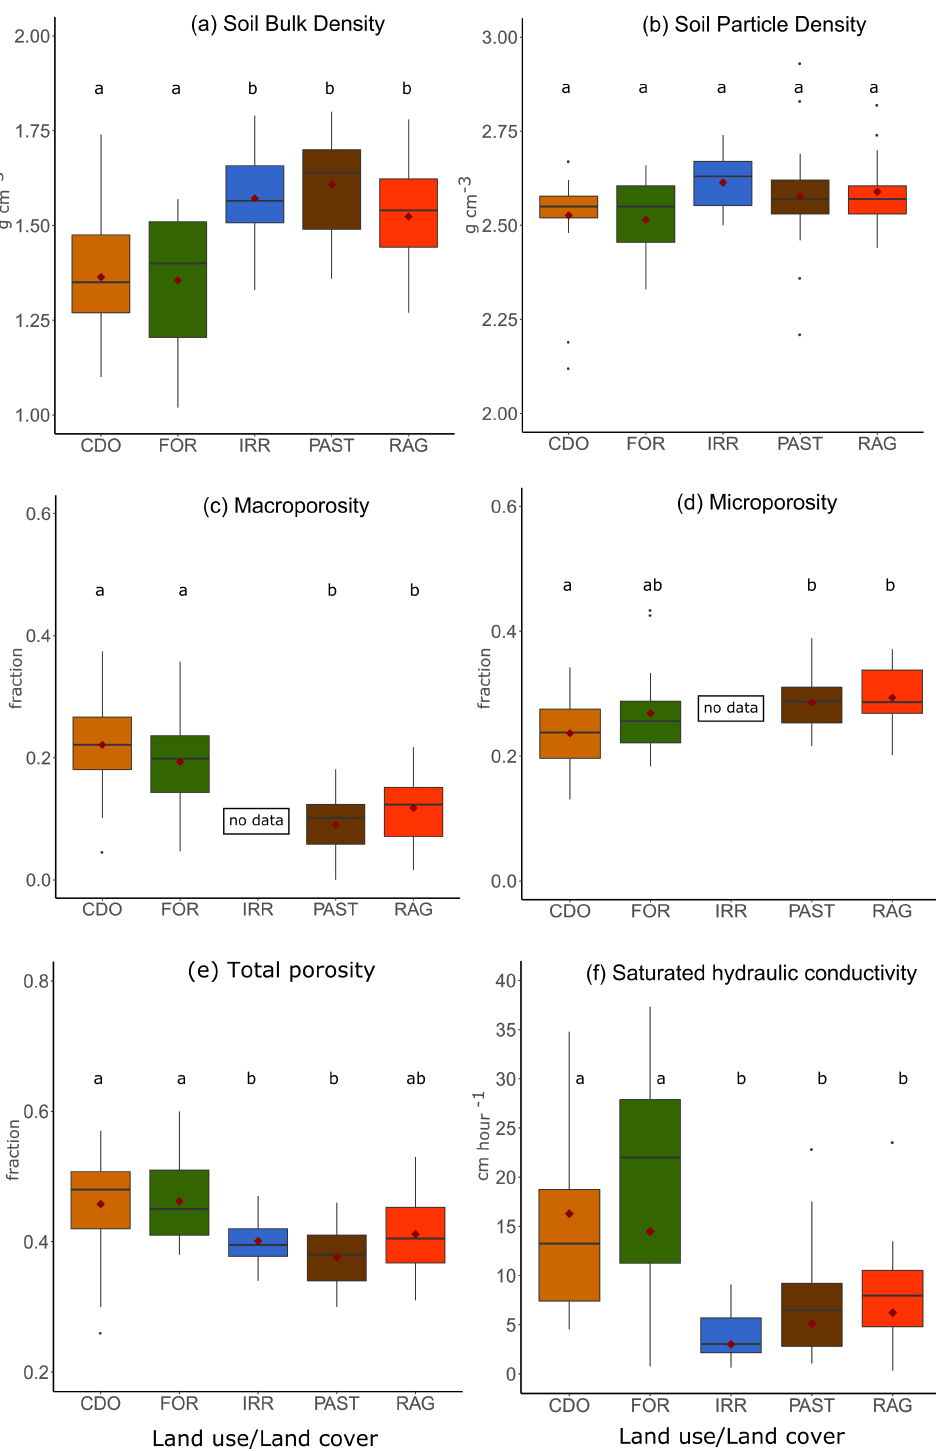
Figure 3. Soil hydraulic and physical properties considering 0–5 cm depth for different LULCCs in Western Bahia.In the box plots, the lower limit of the box indicates the 25th percentile, the black line within the box marks the median, the red point within the box marks the mean, and the upper limit of the box indicates the 75th percentile. Bars above and below the box indicate the confidence interval. The samples are distributed in Cerrado areas (CDO), n = 22; Forest formations (FOR), n = 19; Irrigated agriculture (IRR), n= 20; Pasture (PAST), n = 21; and Rainfed agriculture (RAG), n = 20. Different letters means that averages are statistically different according to Tukey Cramer test at α =